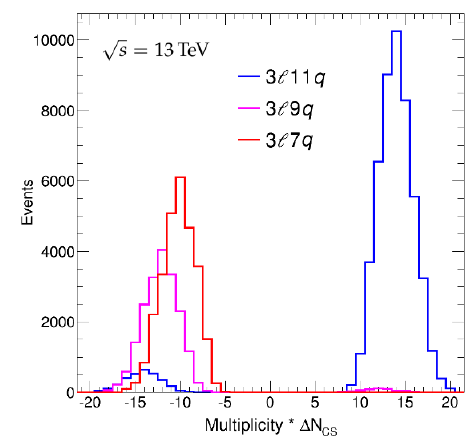
Figure 4 . Left Panel: distributions of the scalar sum of p jet at 13, 14, 28, and 33 TeV. Right Panel: distributions of (cid:0) E T in simulated LHC collisions at all four energies. These simulations are made with the nominal E Sph = 9 TeV.